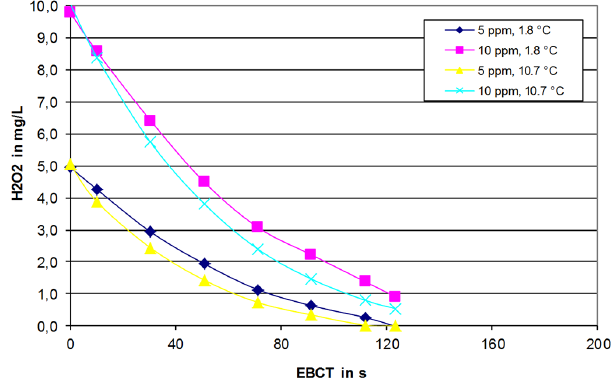
Figure 6. Up flow decomposition with MC in R20 (static bed height 0.36m, water temperature 5.8 ◦ C).